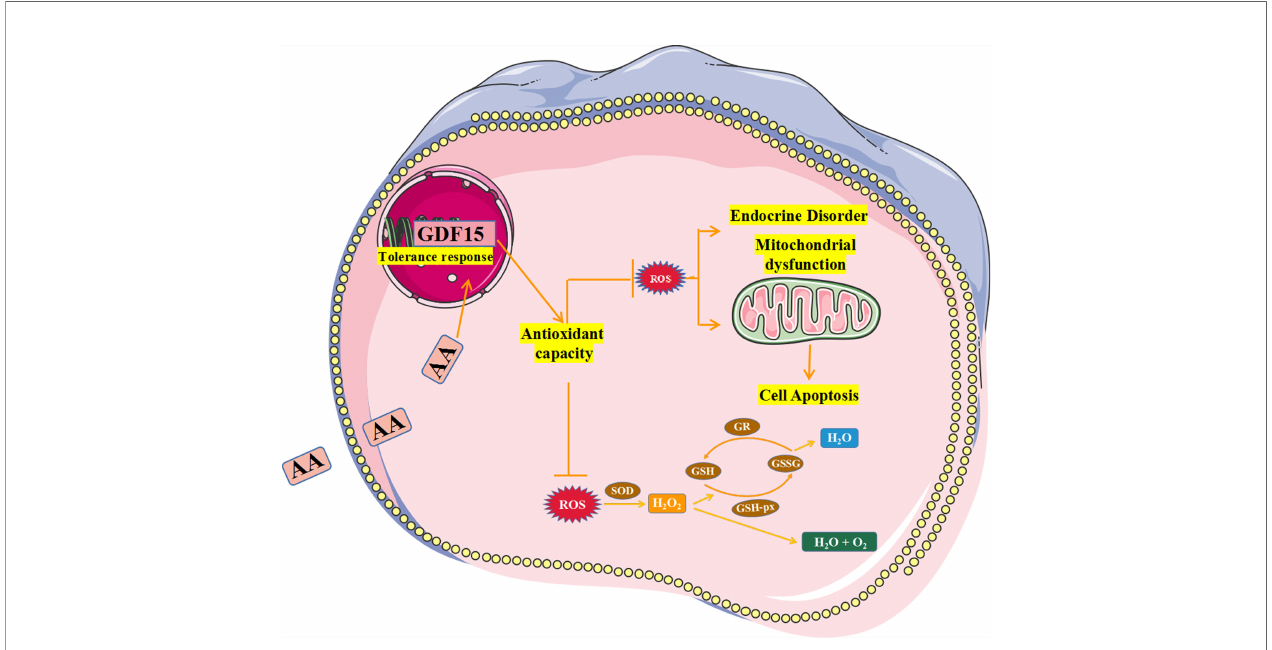
FIGURE 11 | Schematic summarizing the effect and mechanism of AA inducing KGN cells oxidative stress. AA weakened the KGN cells antioxidant capability by increasing ROS level and inhibiting activity of antioxidant enzymes.In addition, AA caused damage to secretory and mitochondrial functions of KGN cells and promoted cell apoptosis. Therefore, AA induces OS in KGN cells and upregulates the expression of GDF15 as a protective response against